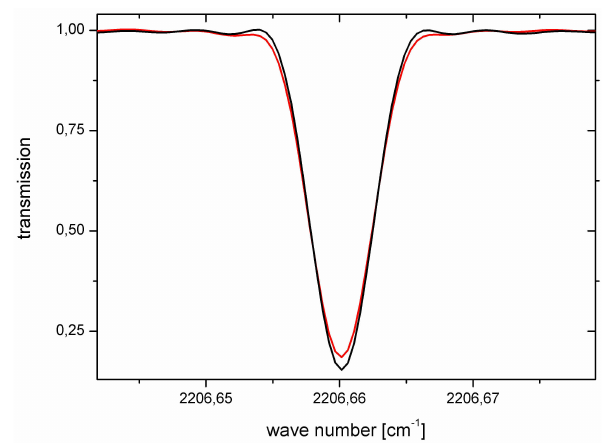
Fig. 9. Small spectral section out of the spectra recorded with the sealed cell C2 in July (black) and October (red). Although the mod- ulation efficiency did not change significantly, the lines are signifi- cantly broader in October, indicating a pressure rise in C2.